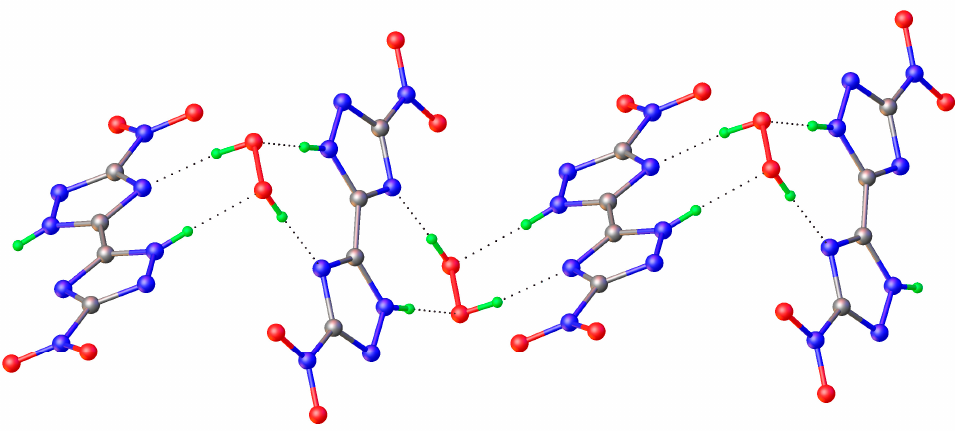
Figure 18. H-bond network in DNT crystal solvates [77].